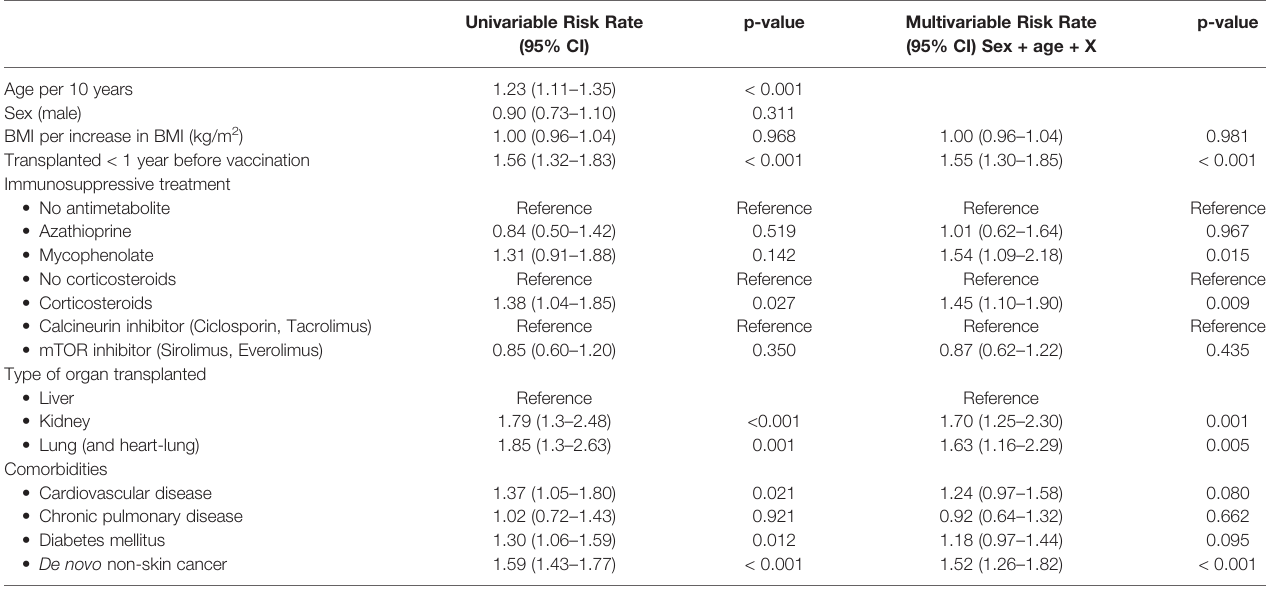
TABLE 3 | Risk factors of humoral non-response 6 months after the fi rst vaccine dose.